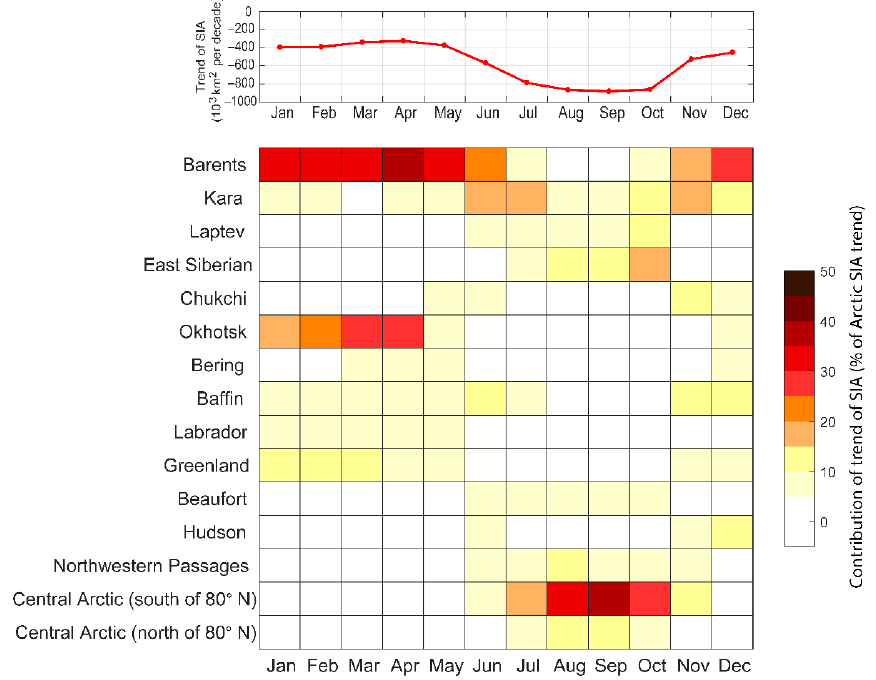
Figure 3. Northern hemisphere SIA trends in 1979–2019 for different months ( top ) and the contri- bution of trends in individual Arctic regions to total northern hemisphere SIA trend ( bottom ) (Con- tributions exceeding 5% are shaded).